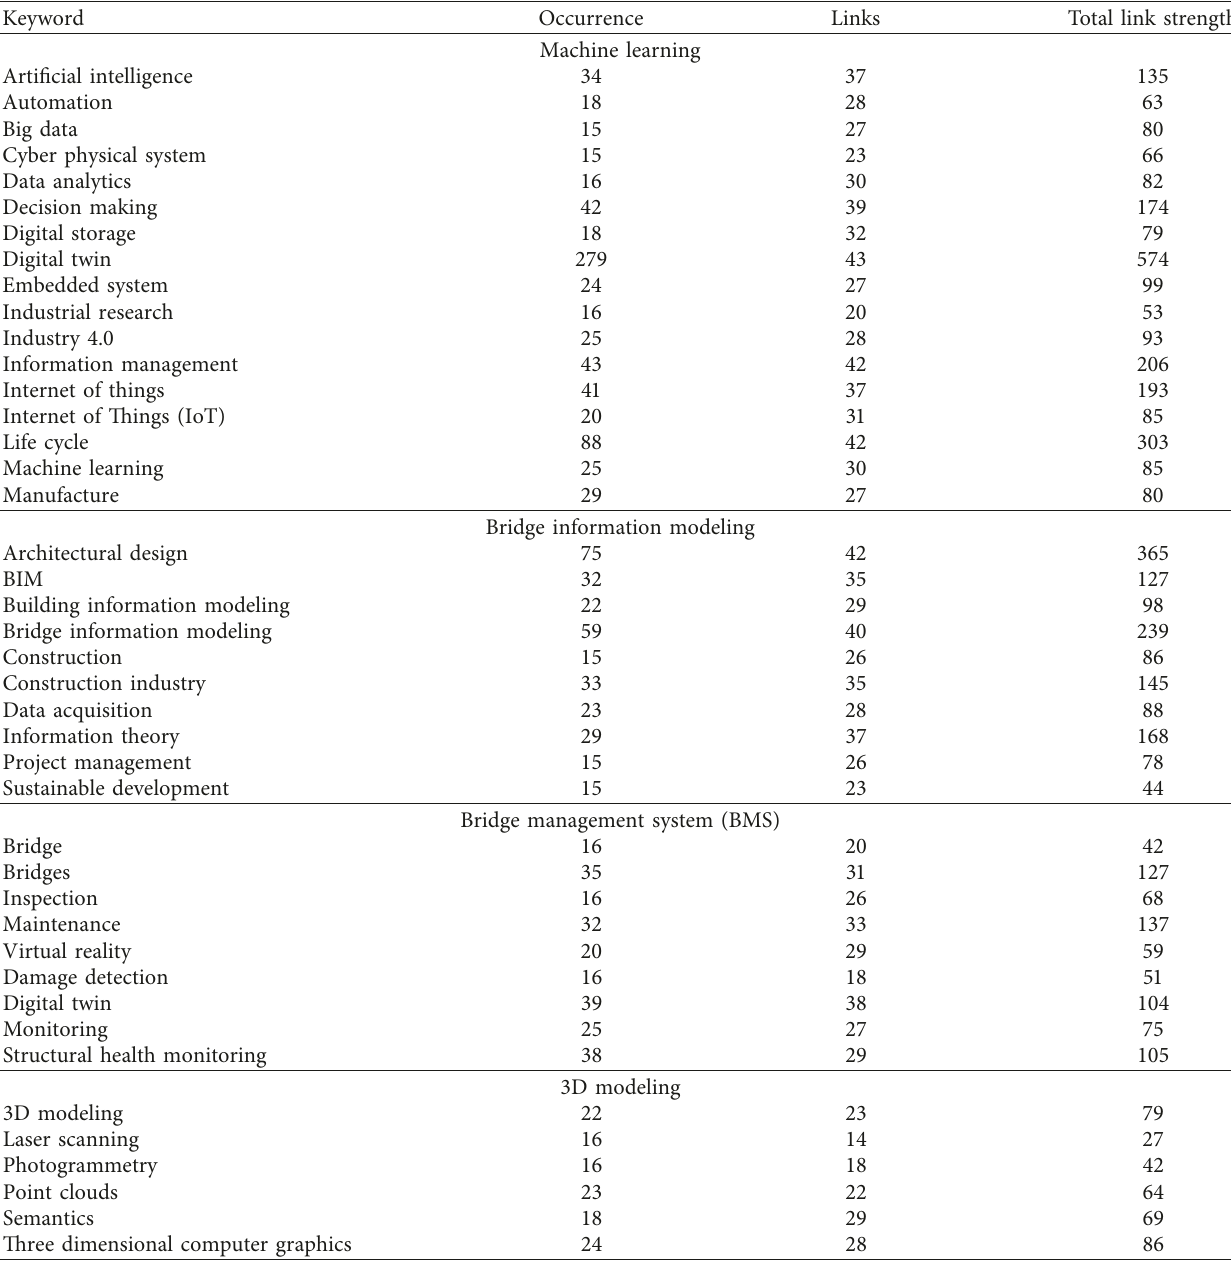
Table 2: Keywords linked to network